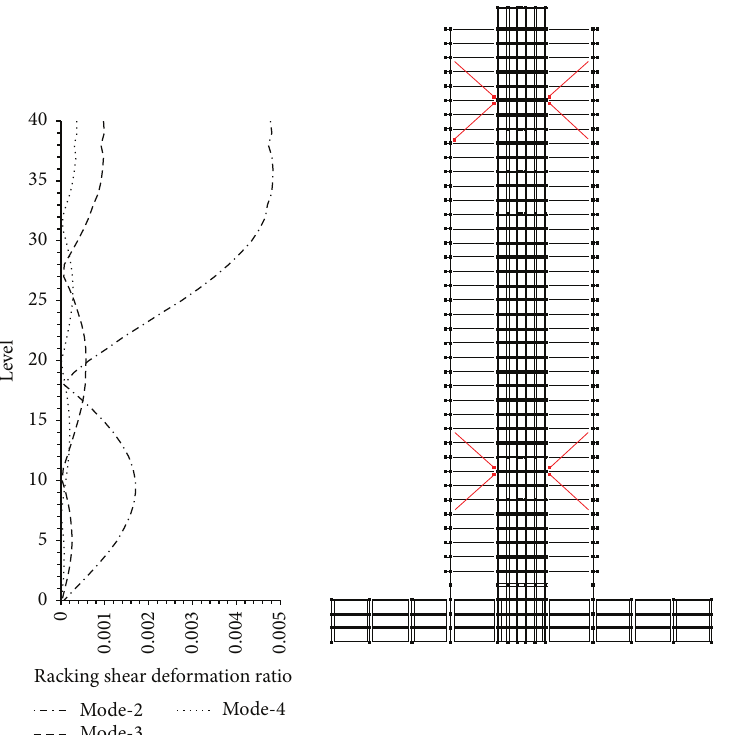
Figure 7: Arrangement of the BRBs at locations of maximum racking shear deformation in exterior panels (Option-2).